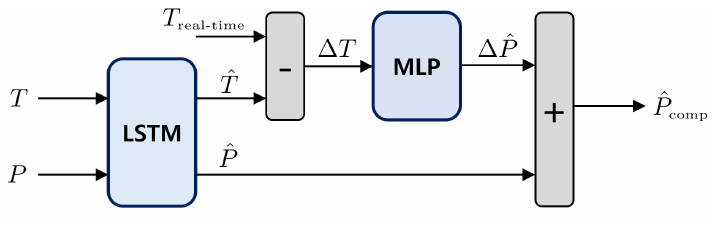
Figure 2. Entire structure of the forecast